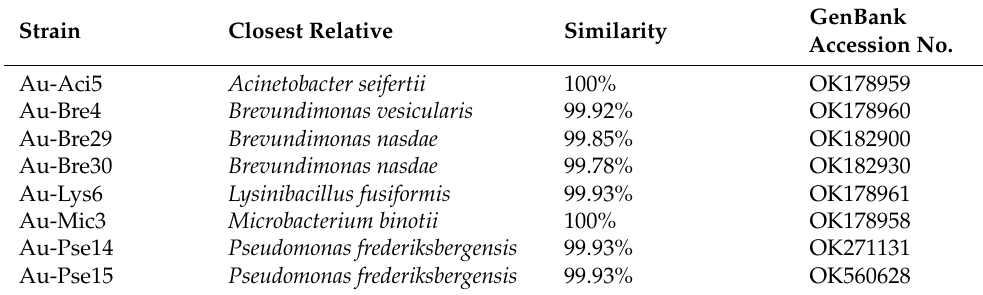
Table 2. Eight Au enrichment isolates from the Zijin gold and copper mine.